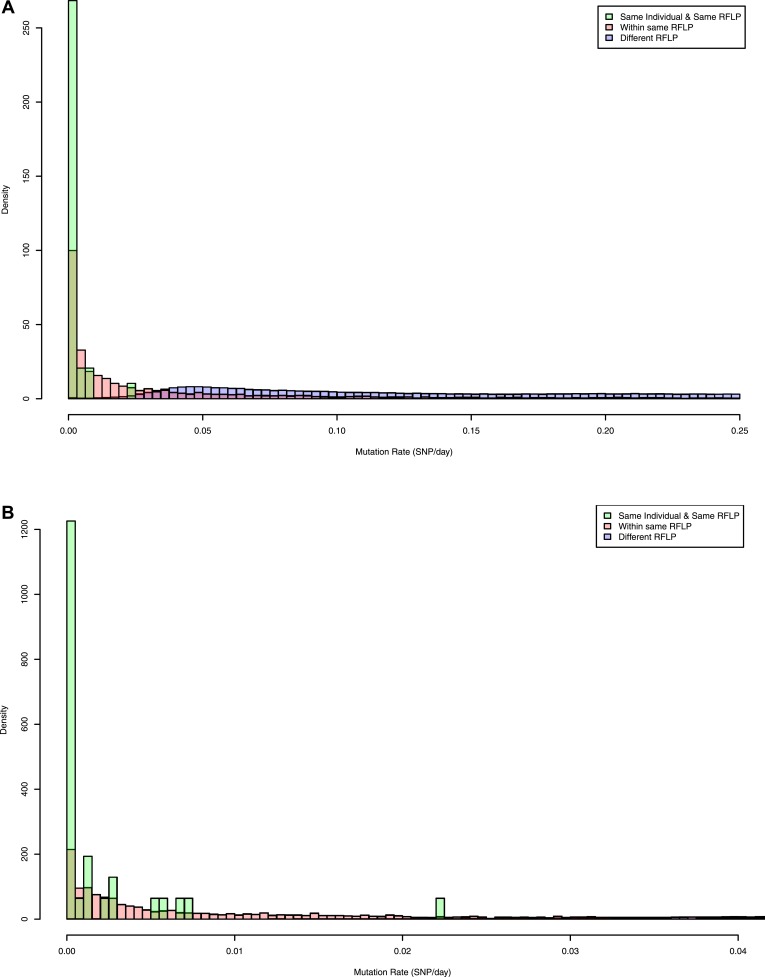
Pairwise mutation rates between all pairs of samples with known RFLP
(calculated as number of SNPs/number of days between dates of disease
onset between individuals).The y axis shows the relative frequency within each subgroup: same RFLP
pattern (red), different RFLP patterns (blue); same individual, same RFLP
(green). (A) shows the full data set, and (B)
is part of the same figure drawn at a larger scale (each bar corresponds
to 0.001 SNP/day) to show the smaller distances more clearly.